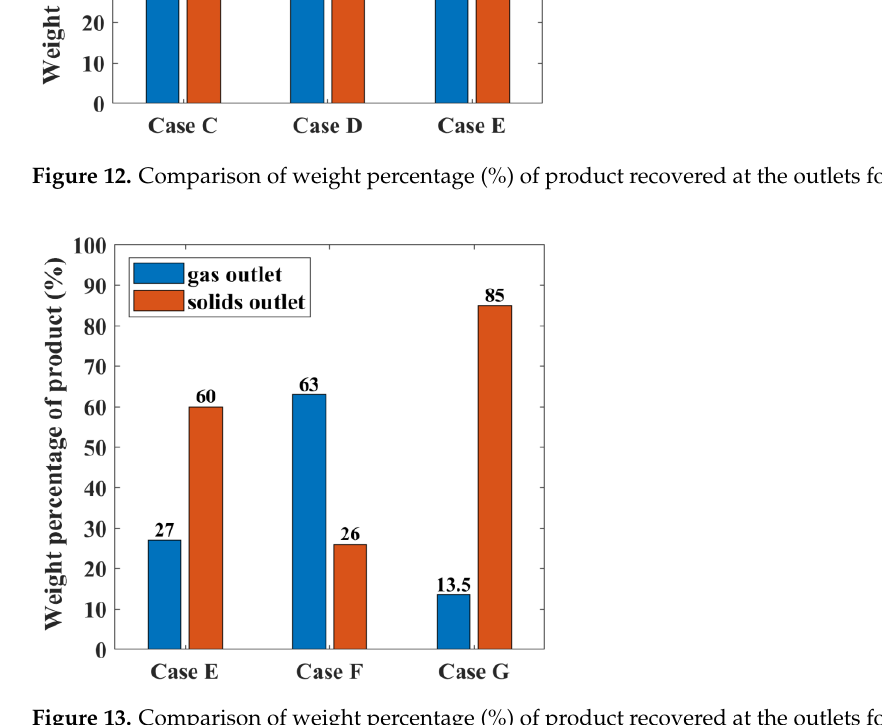
Figure 13. Comparison of weight percentage (%) of product recovered at the outlets for cases E – G.